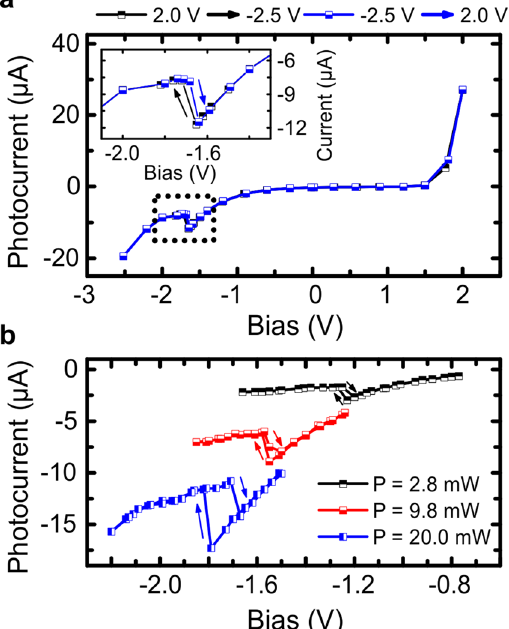
Figure 4. Photocurrent readout and bistable switching. ( a ) Measured photocurrent in forward as well as in reverse direction for an excitation power of 20 mW, with the pump spot approximately 25 µ m away from the center of the contact. The black and blue squares indicate the varied voltage from 2.0 V to − 2.5 V as well as from − 2.5 V to 2.0 V, respectively. Between − 1.62 V and − 1.72 V a negative differential resistance is visible in the photocurrent corresponding to the on-/off-state of the device. The inset shows a zoom into the region of negative differential resistance. ( b ) By moving the pump spot closer to the contact, which means approximately to a distance of 15 µ m to the center of the contact, the nonlinearity shows a bistable behavior with upward and downward directed bias. By varying the pump power and therefore the injected carrier density the bistability emerges at 20 mW or vanishes for lower excitation